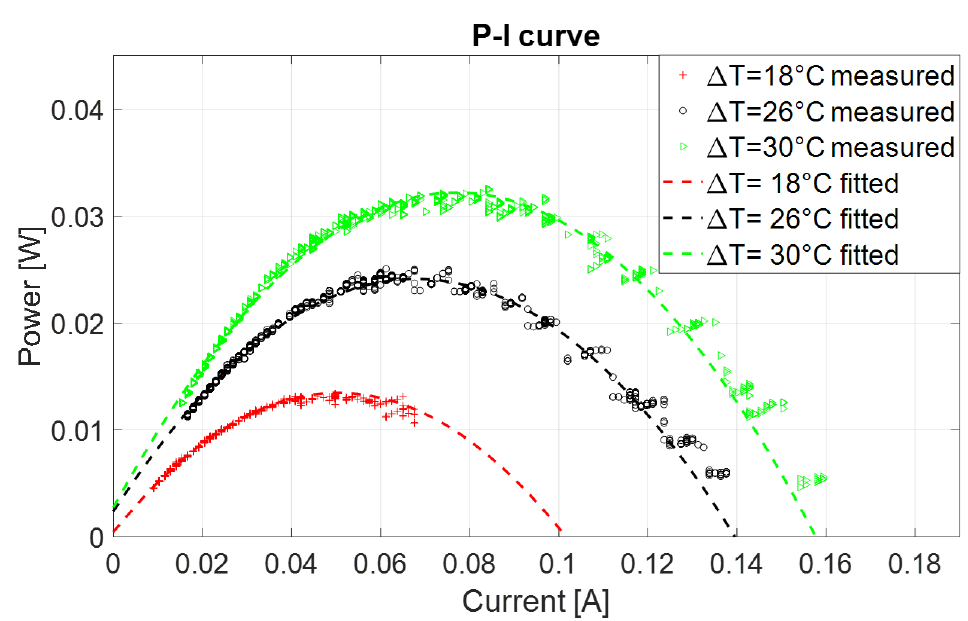
Figure 4. P-I characteristic curve measured (scatter plots) and fitted (dashed lines) at three tempera- ture gradients: ∆ T = 18 °C (red plots), ∆ T = 26 °C (black plots) and ∆ T = 30 °C(green plots).